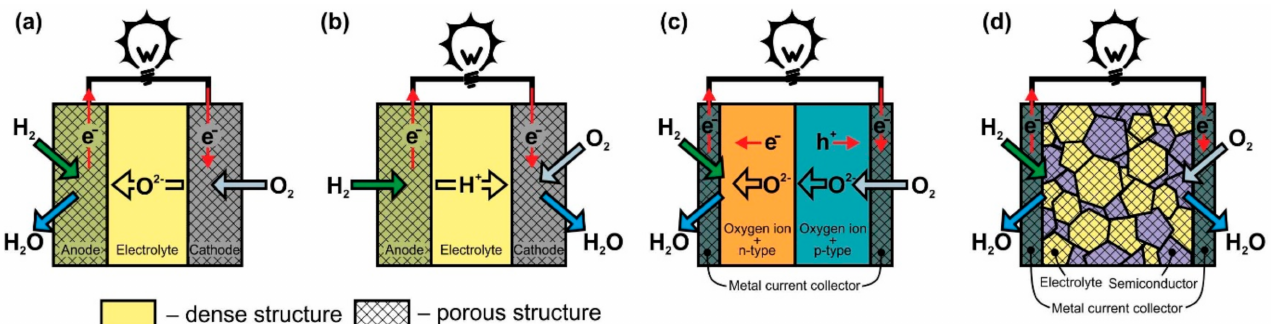
Figure 1. Scheme of operation of ( a ) oxygen-ion conducting electrolyte SOFC (O-SOFC), ( b ) proton- conducting electrolyte SOFC (H-SOFC), ( c ) double-layer fuel cells (DLFC), and ( d ) single-layer fuel cells